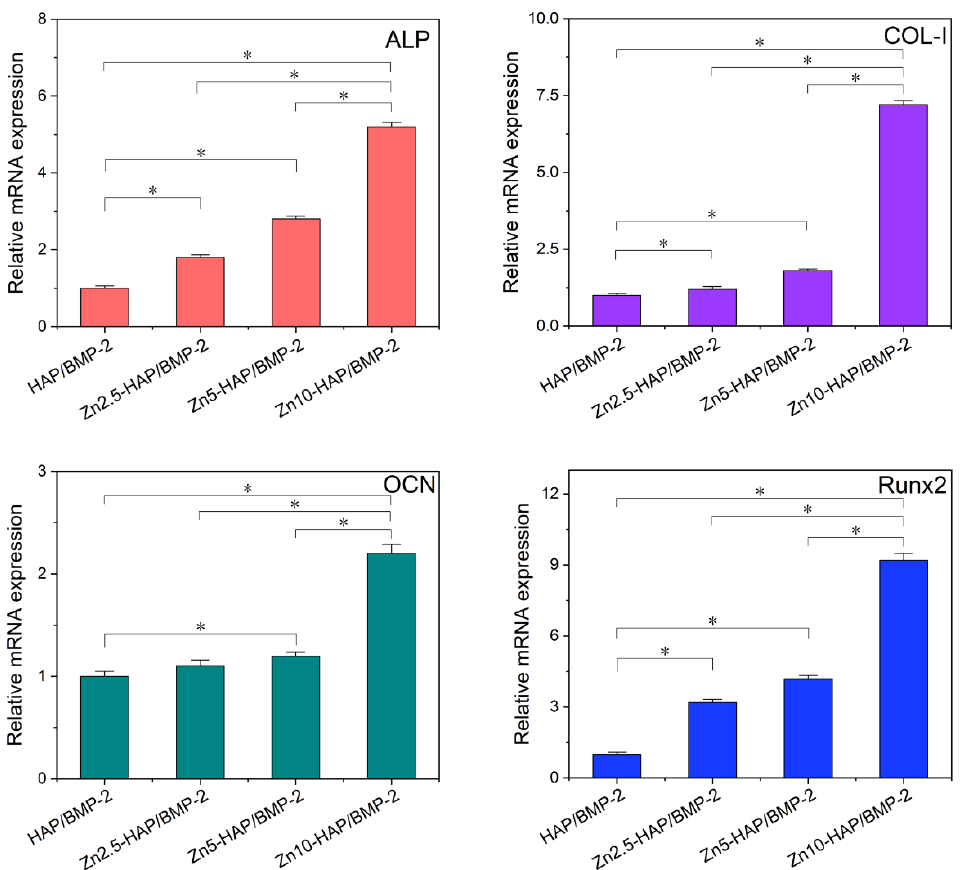
Figure 7. Relative osteogenic genes (ALP, COL-I, OCN, and Runx2) expression of C2C12 cells after incubation with HAP/BMP-2 and Zn-HAPs/BMP-2 for 3 days. Expression levels are normalized with total GAPDH content and the HAP/BMP-2 group. * p < 0.05, compared with corresponding samples.